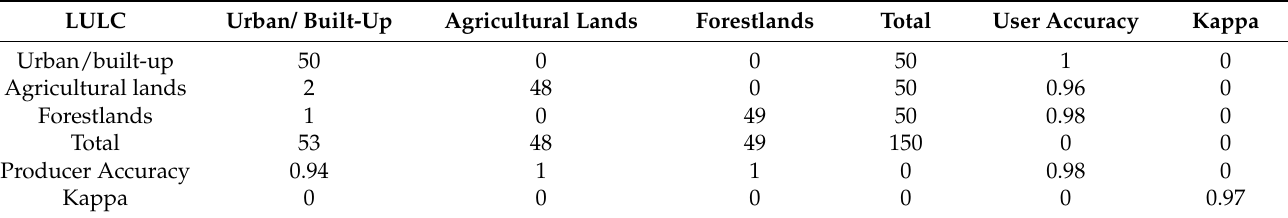
Table A3. User, Producer and Kappa statistics for the classified image of